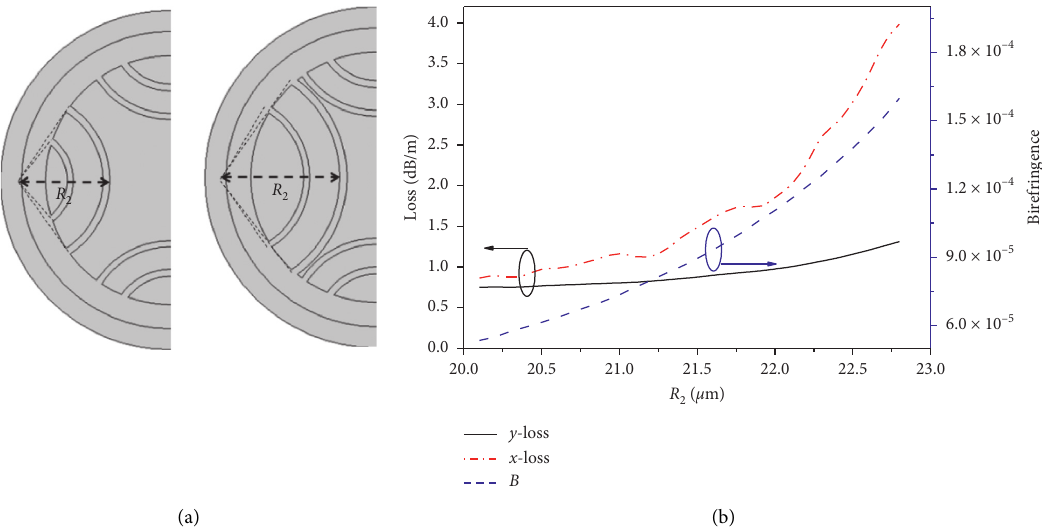
Figure 6: (a) The center of the circle is fixed and R 2 is changed. (b) x and y polarization mode loss and birefringence as a function of R 2